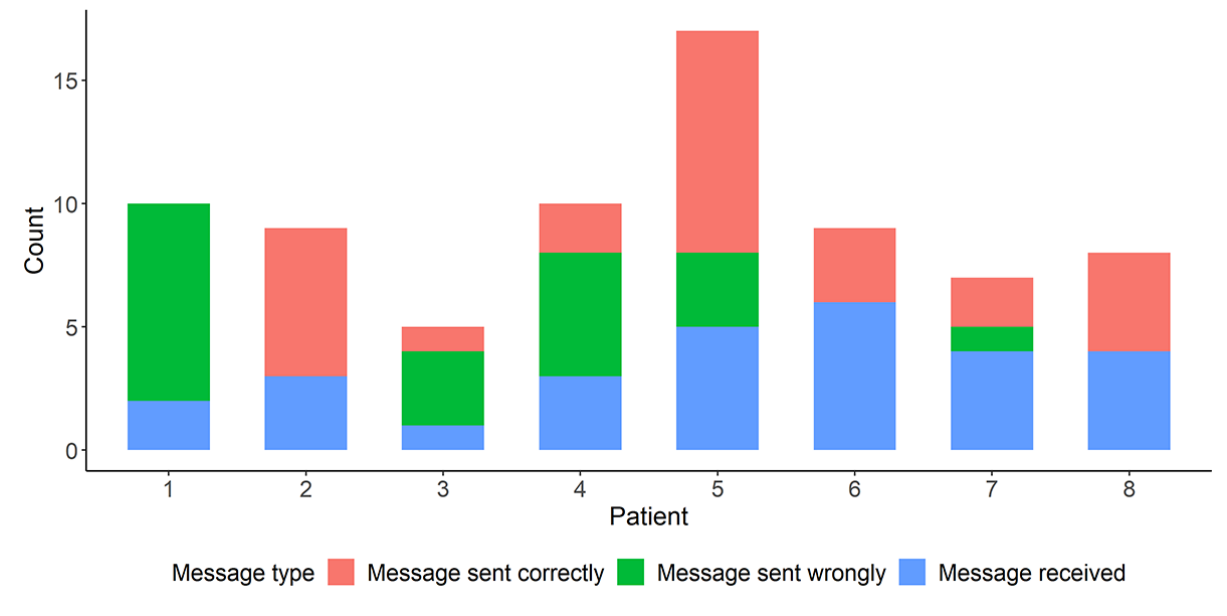
Figure 8. Number of messages sent to and from the